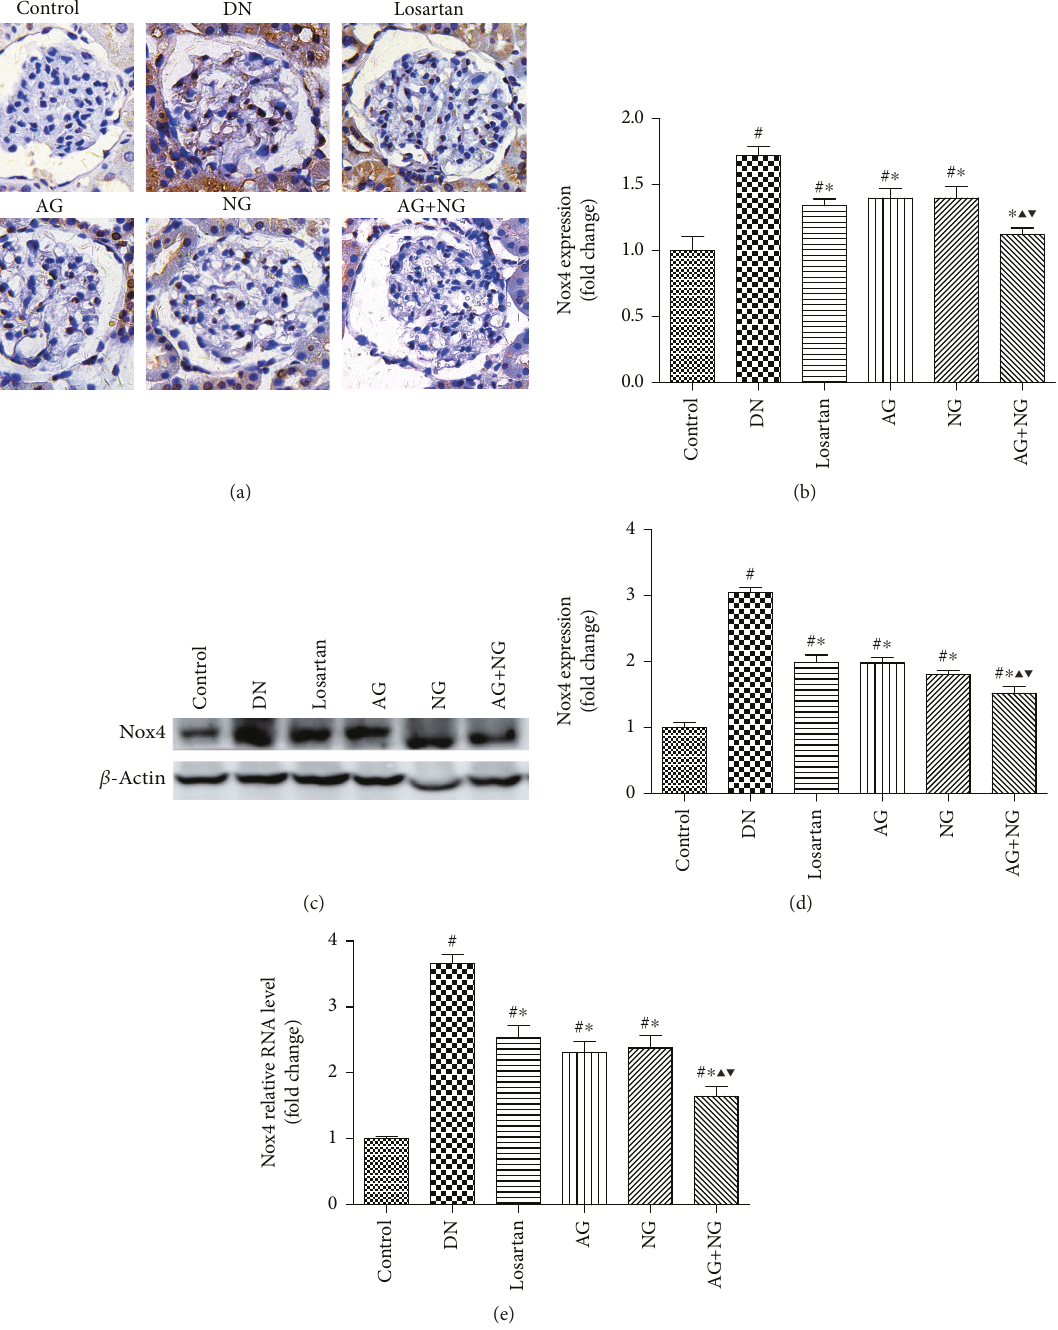
Figure 7: E ff ects of AG and NG on NADPH oxidase 4 (Nox4) in diabetic rats. Representative photomicrographs of immunostaining (a) and western blots (c) for Nox4 in the glomeruli of kidney sections. Semiquantitative analyses of immunostaining (b) and western blots (d) for Nox4. Glomerular relative mRNA levels of Nox4 (e). Control: normal control rats; DN: STZ-induced diabetic rats; losartan: DN rats treated with losartan; AG: DN rats treated with Astragalus membranaceus; NG: DN rats treated with Panax notoginseng; AG+NG: DN rats treated with Astragalus membranaceus plus Panax notoginseng. Results were expressed as the mean ± SD . # P < 0 05 vs. control group, ∗ P < 0 05 vs. DN group, ▲ P < 0 05 vs. AG group, ▼ P < 0 05 vs. NG